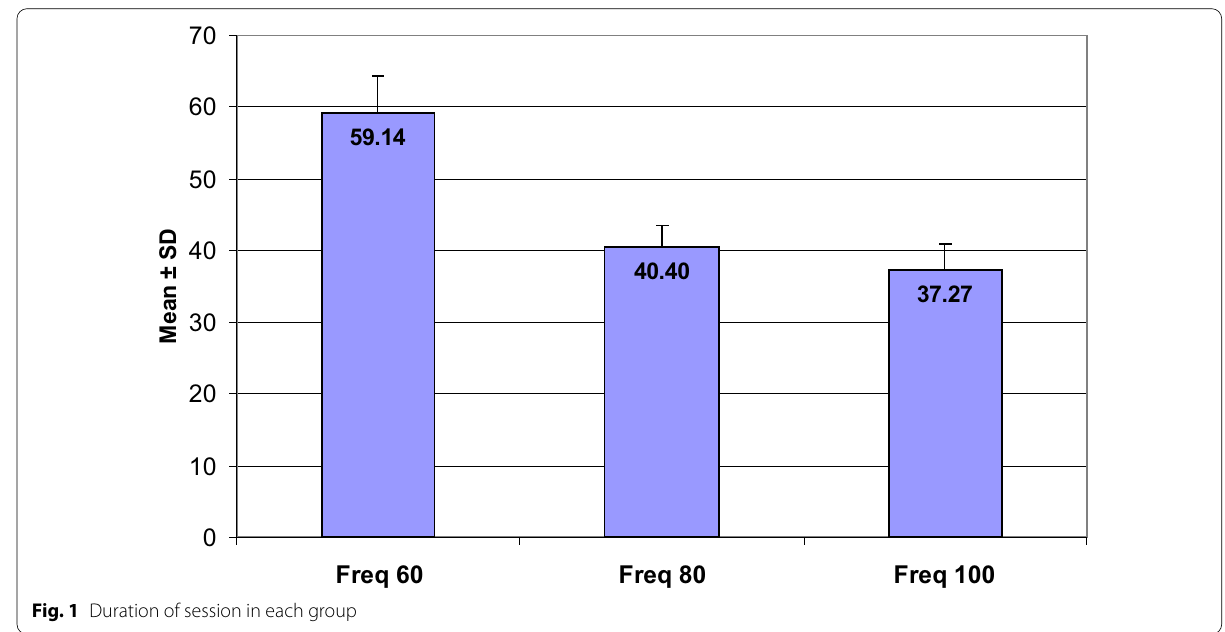
Fig. 1 Duration of session in each group